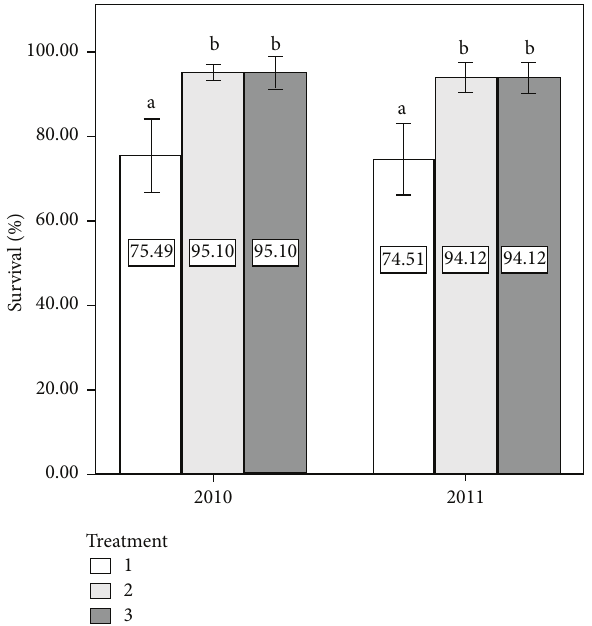
Figure 1: Survival rate (%) of argan seedlings for 2010 and 2011. Treatment 1: control. Treatment 2: seedlings with 120cm shelters. Treatment 3: seedlings with 150cm shelters. Values sharing the same letter within the same year are not significantly different at 5% level (Scheff´e test).